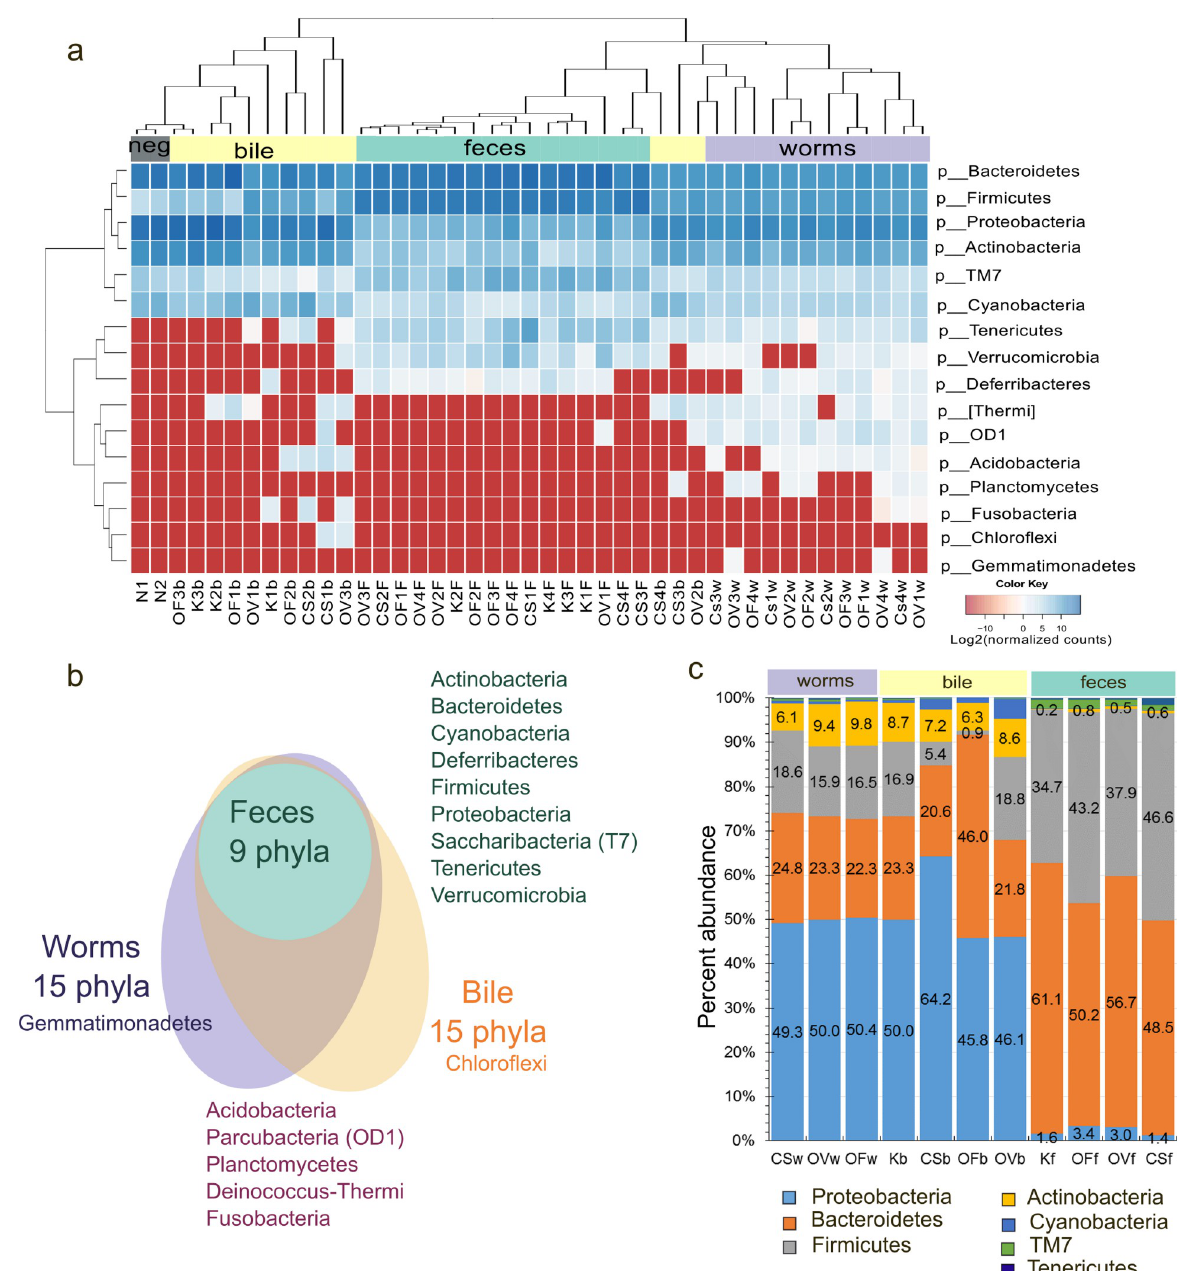
Fig 2. Taxonomic diversity of the samples prepared from feces, bile and worms. a. The heatmap illustrating relative abundance of taxa at the phylum level. Neg: negative control samples (no-DNA control). b. The Venn diagram of phyla distribution among samples of feces, bile of hamsters, and worms. c. The boxplot of the distribution of seven major bacterial phyla from microbial communities of worms, feces, and bile of hamsters. The average percent abundance is presented. K: uninfected animals; N: negative control; OF: O . felineus , CS: C . sinensis , OV: O . viverrini , f: feces, b: bile, w: worms.